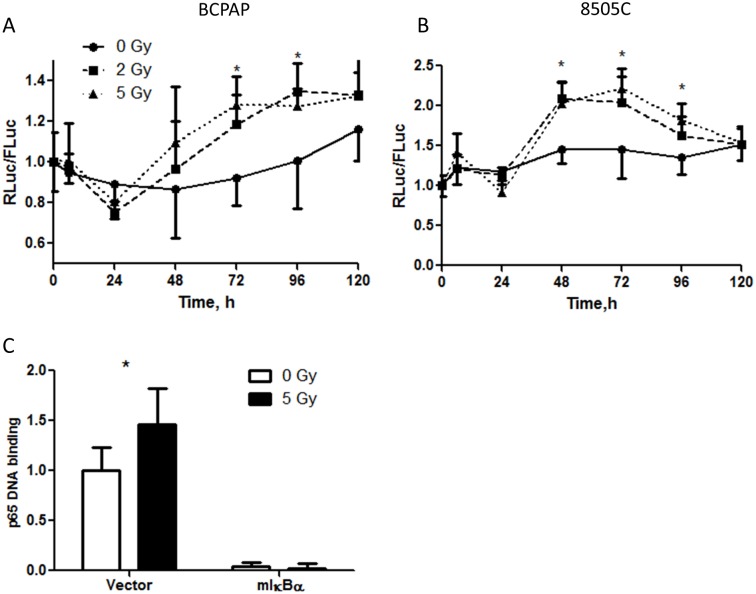
The ionizing radiation activates NF-κB signaling in BCPAP (A,C) and 8505C (B) thyroid cancer cells as measured by dual luciferase reporter assay (A, B) and p65 DNA binding ELISA (C).p65 DNA binding experiment was performed 72 h after radiation exposure. Data are normalized to non-irradiated group (at a time 0 h for panels A and B). *—p<0.05, (two-way ANOVA, Bonferroni posttest).